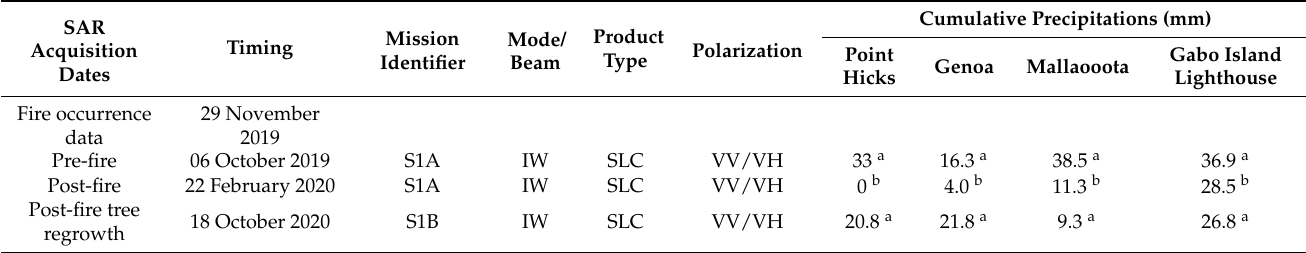
Table 1. The obtained SAR data and cumulative precipitation (mm) three days prior to image acquisition. Historical median values for temperature and precipitation over the study period are also provided.